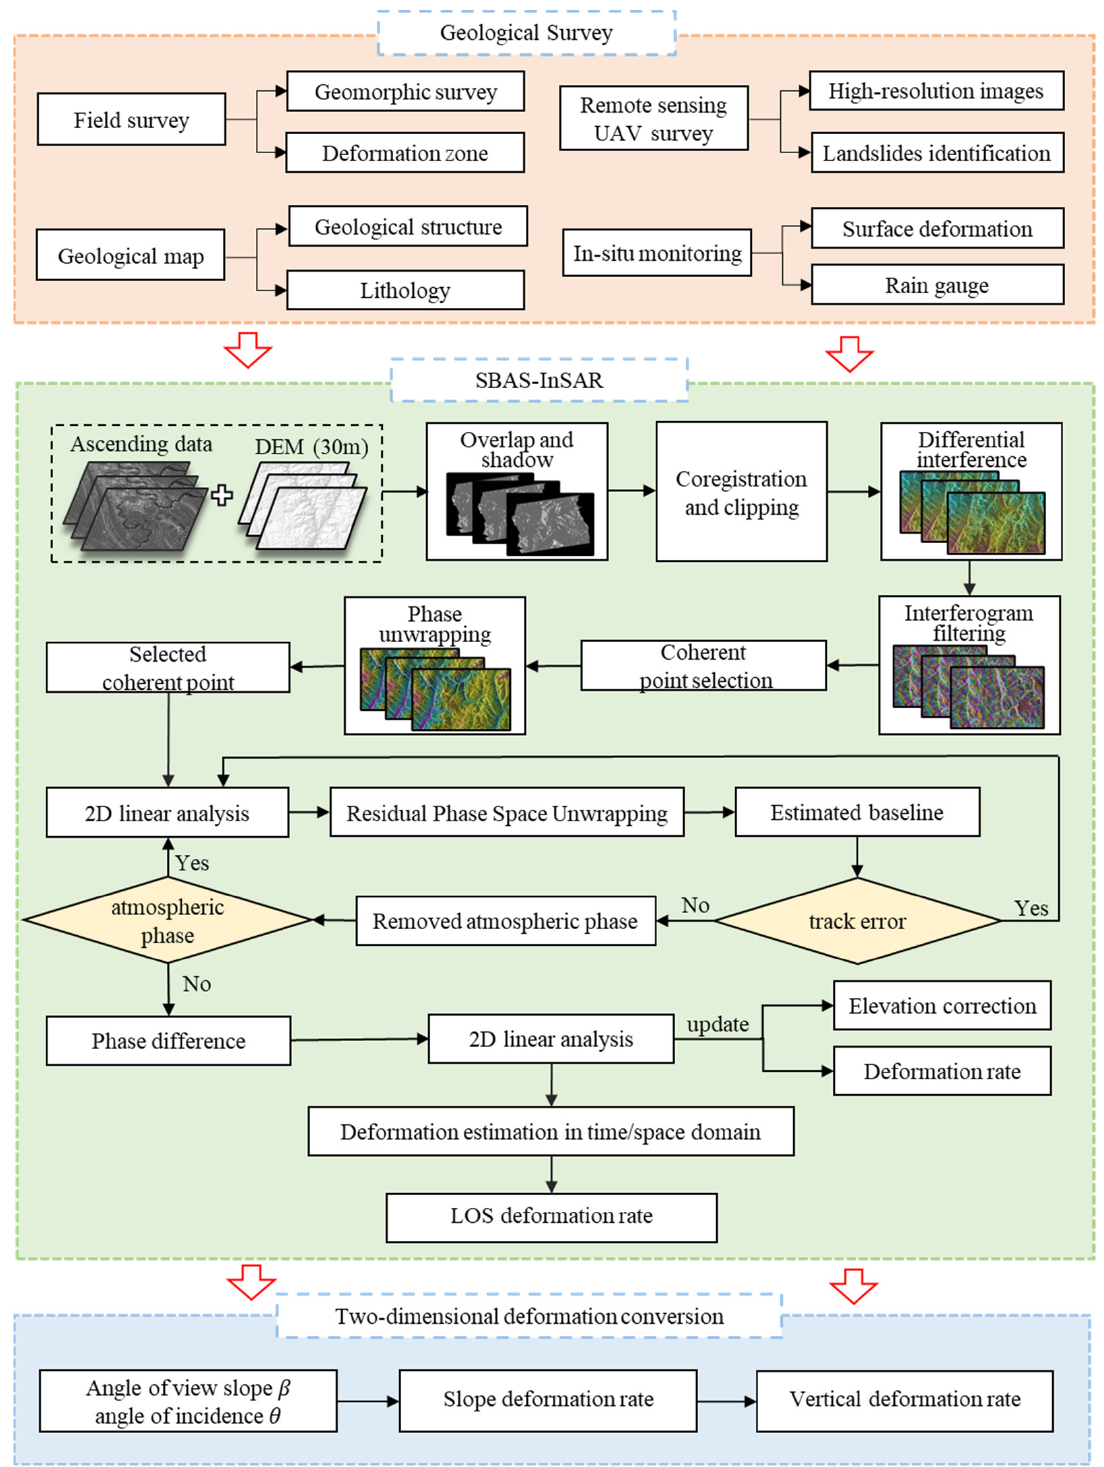
Figure 3. Research methodology map.